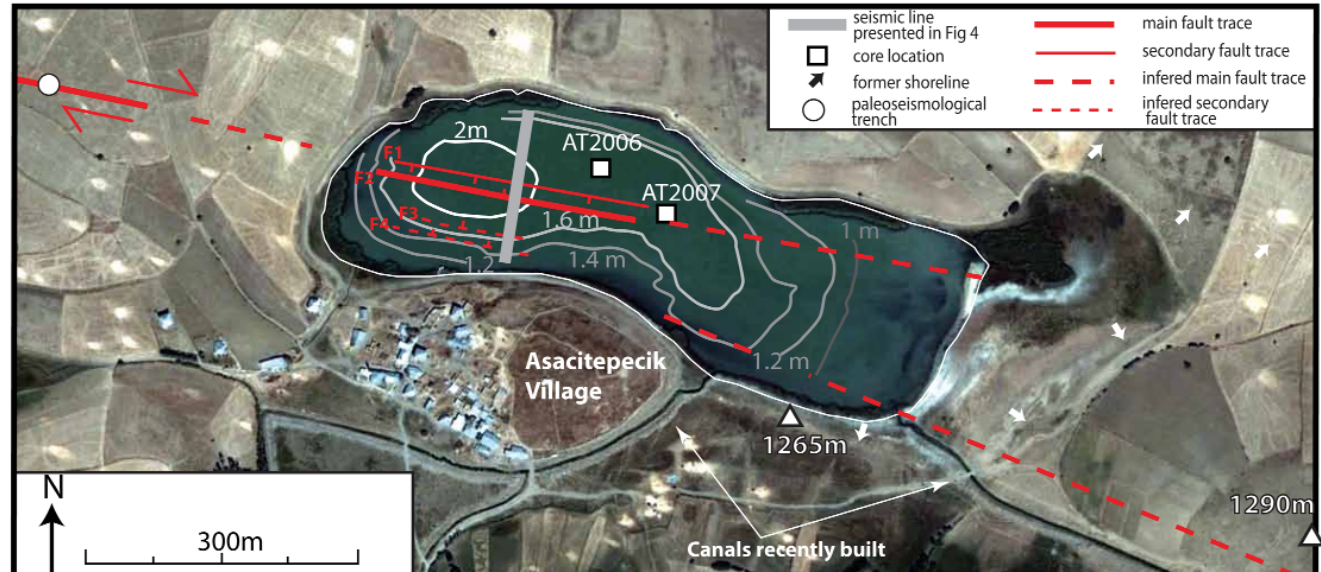
Figure 3. Bathymetry of A ş a ğ ıtepecik Lake and the core locations (squares). Continuous red lines indicate fault scarps visible in the seismic lines or in the paleoseismic trench of Zabci et al. [2008] (circle); dashed red lines indicate the inferred fault geometry. Different labels (F1, F2, F3 and F4) are used for the fault scarps identified in the seismic lines (see Figure 4). Lake bathymetry was measured in July 2006 with sonar GPS. The A ş a ğ ıtepecik village lies along the southern shore of the lake as well as water canals recently built after 2000 for irrigation purpose. The lake is in continuity with the flood-plain of the Cobali River (see Figure